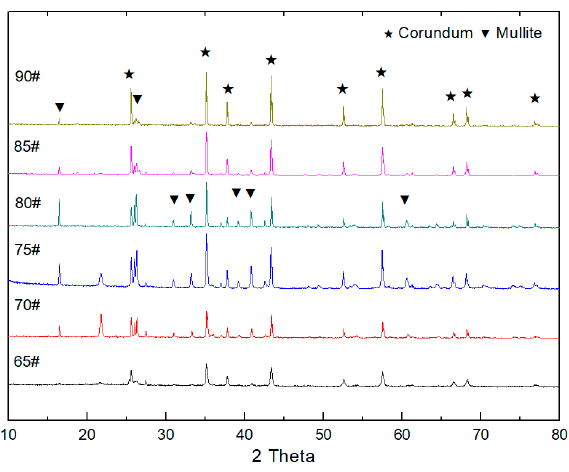
Figure 7. XRD patterns of calcined bauxite. Table 6. Main mineral components of calcined bauxite.